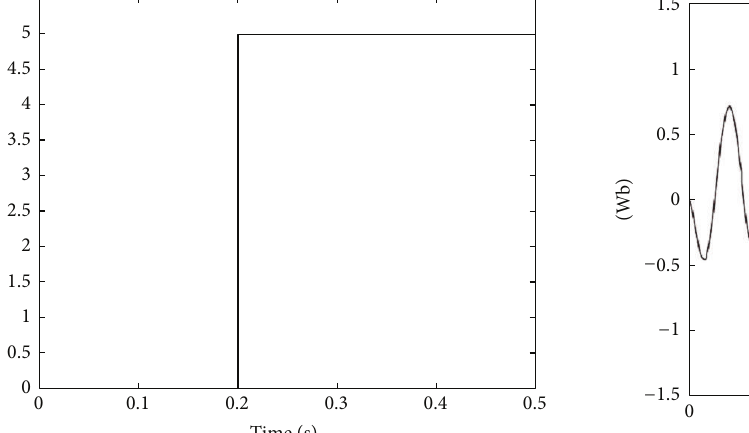
Figure 12: Estimated flux ̂𝜑 𝑏 .